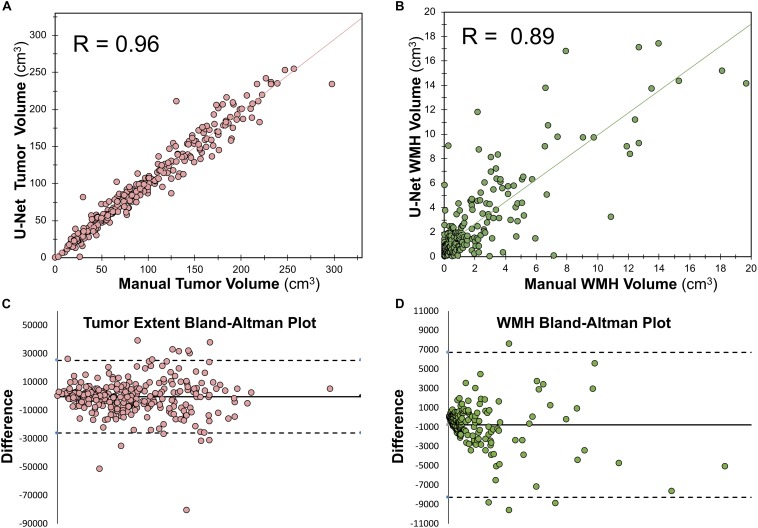
Relationship between manually segmented volume and U-Net predicted volume. (A) Pearson correlation between manually segmented tumor volume and U-Net predicted tumor volume. (B) Spearman ranked correlation between manually segmented WMH volume and U-Net predicted WMH volume. (C) Bland–Altman plot for WT manually segmented volume and U-Net predicted volume. (D) Bland–Altman plot for WMH manually segmented volume and U-Net predicted volume. The dotted lines in panels (C,D) mark the bounds of the 95% confidence interval of the bias.